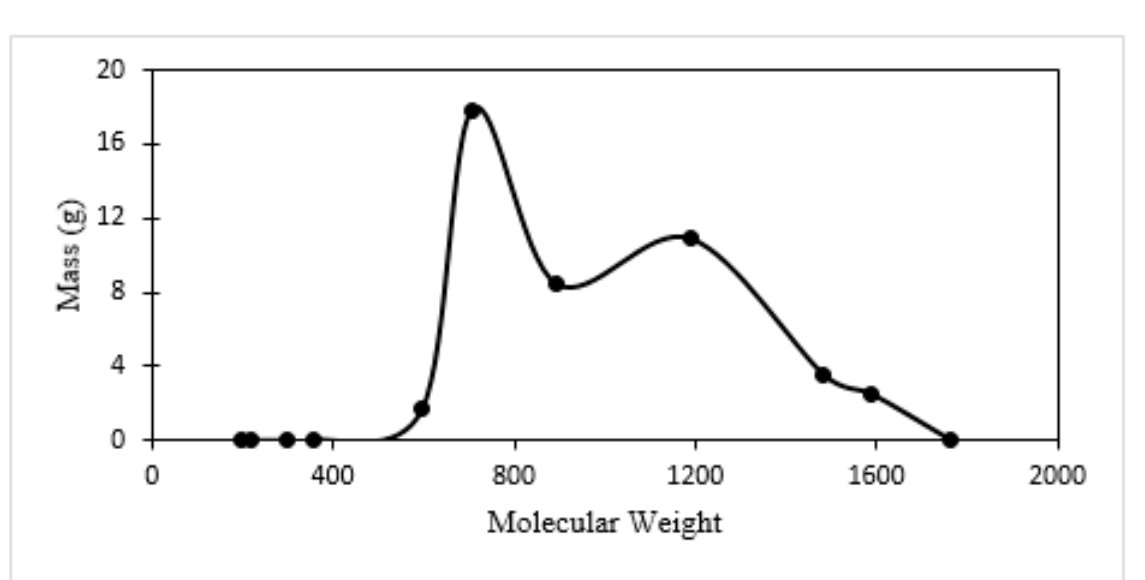
Figure 13. Calculated molecular weight distribution of the residue of a 50 g mass coal tar pitch at the end of the mesophase formation step of the carbonization process with heating rate of 50 ◦